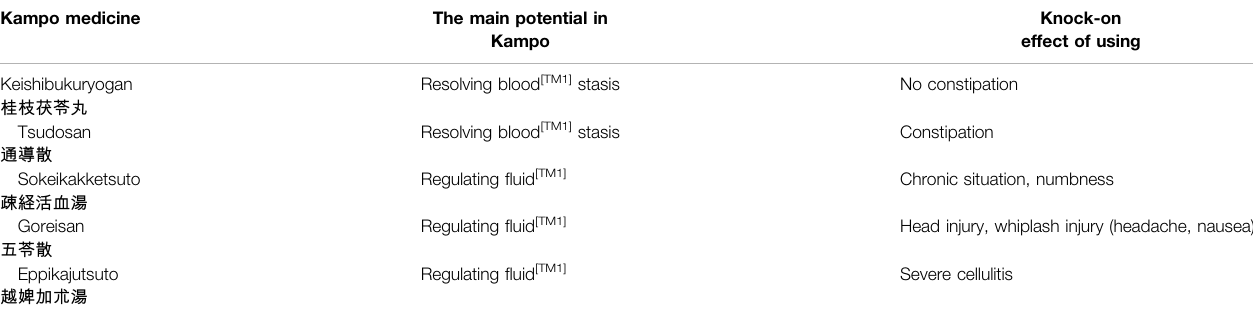
TABLE 4 | Concomitant use of Kampo medicine with jidabokuippo.